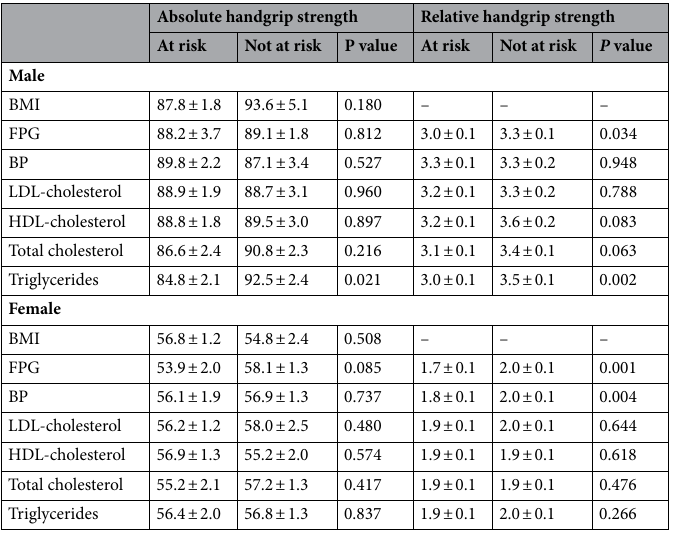
Table 3. Comparisons of handgrip strength between cardiometabolic risk factor categories by sex. Values are mean ± SEM. BMI body mass index, FPG fasting blood glucose, BP blood pressure, LDL low-density lipoprotein, HDL high-density